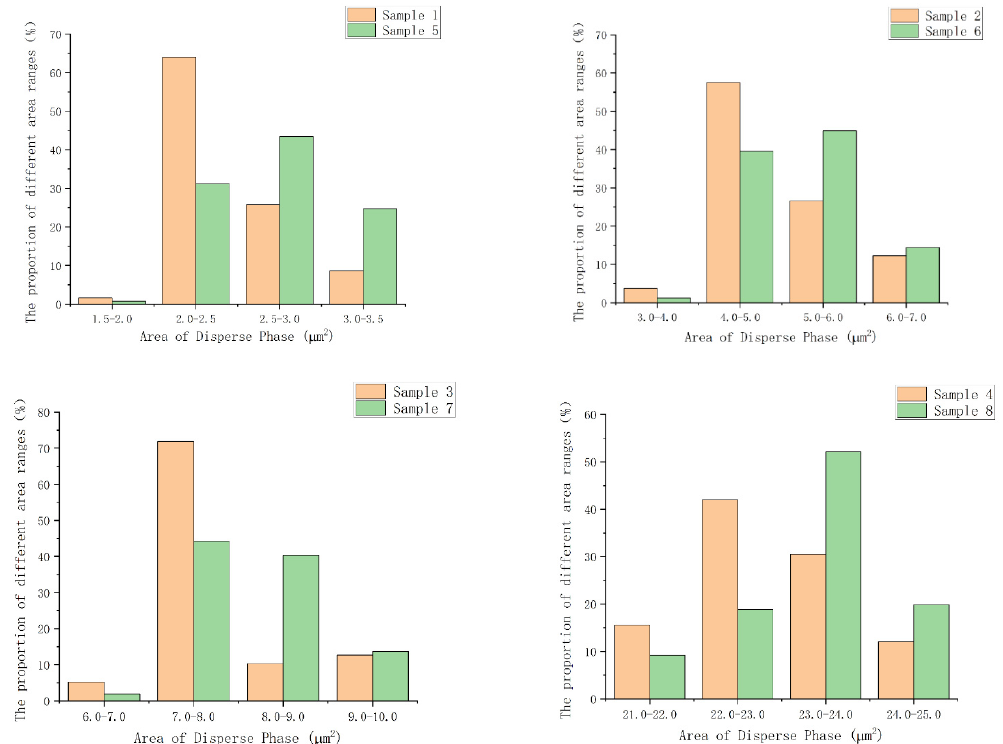
Figure 7. Bar diagrams of the size distribution of the dispersed phase in the backscattered signal diagrams.